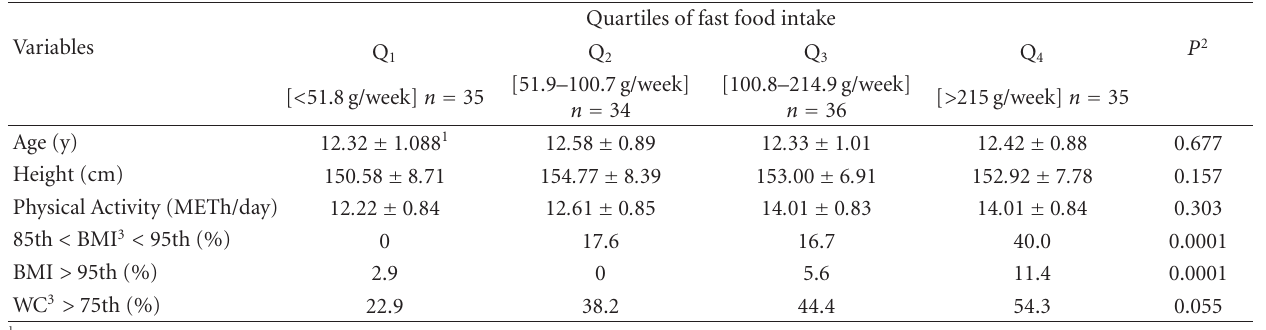
Table 1: Demographic characteristics across the quartiles of fast food